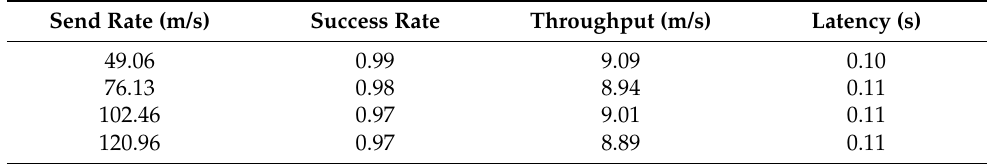
Table 1. Latency and throughput measurements without blockchain.